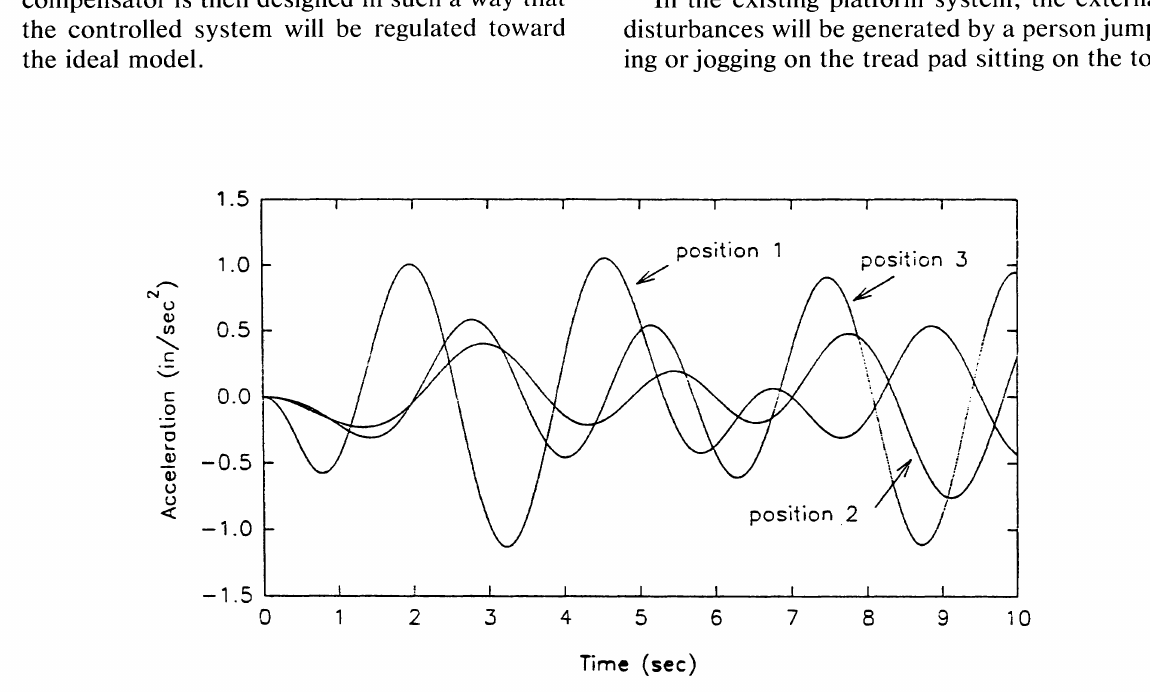
FIGURE 3 Application point of an impulsive force.